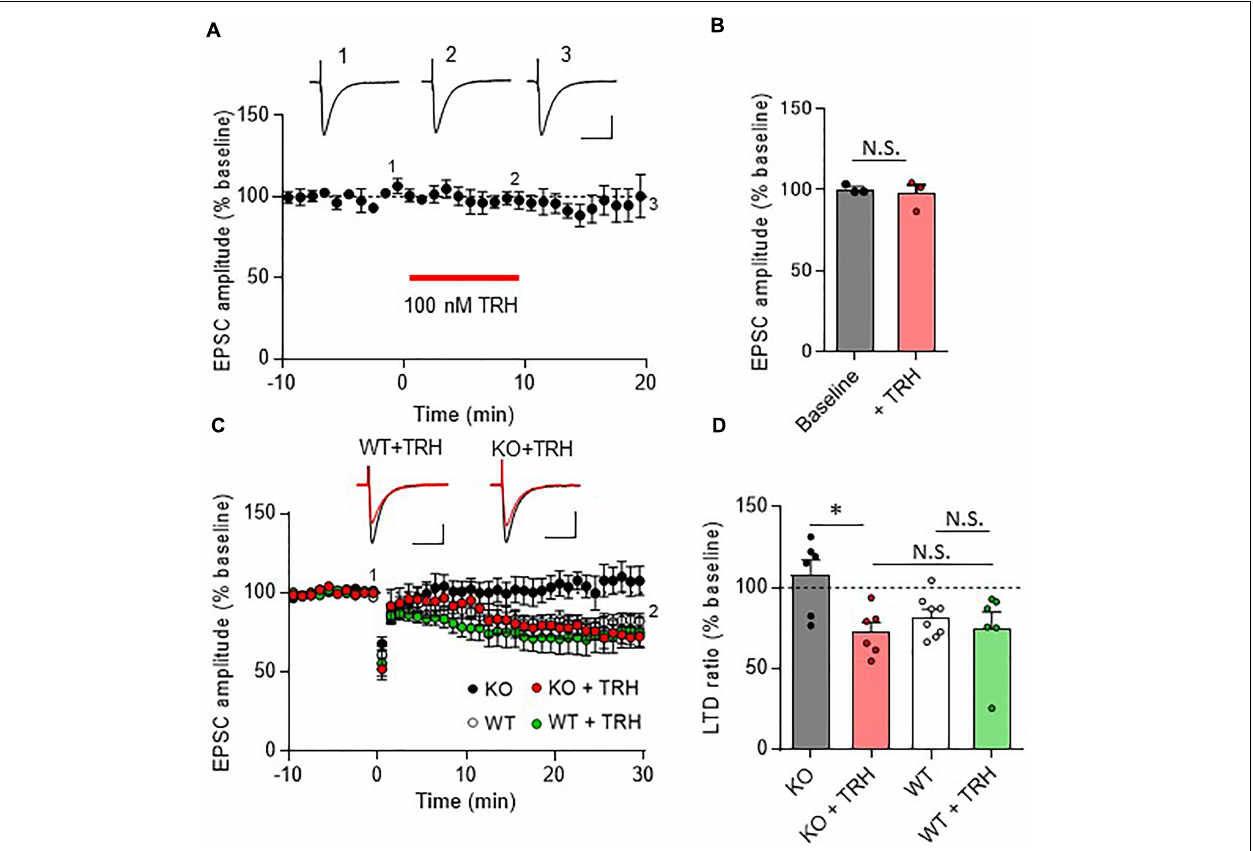
FIGURE 5 | Rescue of cerebellar LTD in TRH-deficient mice following treatment with exogenous TRH. (A) No influence of TRH on the amplitudes of PF EPSCs elicited in TRH-KO mouse PCs. TRH (100 nM) was bath-applied to cerebellar slices for 10 min, as indicated by the red horizontal bar ( n = 3 PCs from three TRH-KO mice). Representative traces before (1) and 10 min after (2) the TRH application and washout (3) are shown. Scale bar: 100 pA, 50 ms. (B) Summary graph showing the effects of TRH on EPSCs, which were calculated by dividing the averaged EPSC amplitude values obtained from –5 to 0 min or 5 to 10 min by those obtained from –10 to 0 min. (C) Cerebellar LTD in the presence of TRH (100 nM). Conjunctive stimulation used for LTD induction was performed at time 0 (KO: six PCs from four mice, WT: eight PCs from five mice, KO + TRH: six PCs from four mice, WT + TRH: six PCs from three mice). Representative traces before (1) and 30 min after (2) the conjunctive stimulation is shown as black and red lines, respectively. Scale bar: 100 pA, 50 ms. (D) Summary graph showing PF EPSC amplitudes 30 min after conjunctive stimulation relative to the baseline (100%). Data from the control KO mice and those from the control WT mice (C,D) , which are the same as those shown in other figures, are presented for comparison. ∗ P < 0.05, as determined using Welch’s t -test. EPSC, excitatory postsynaptic current; KO, knock-out; LTD, long-term depression; N.S., not significant; PF, parallel fiber; WT,